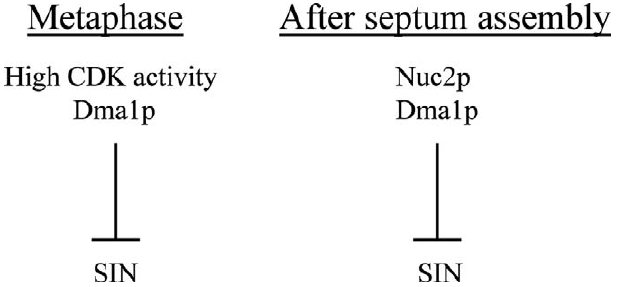
Figure 8. Model Summarizing the Temporal Regulation of Cytokinesis in S. pombe